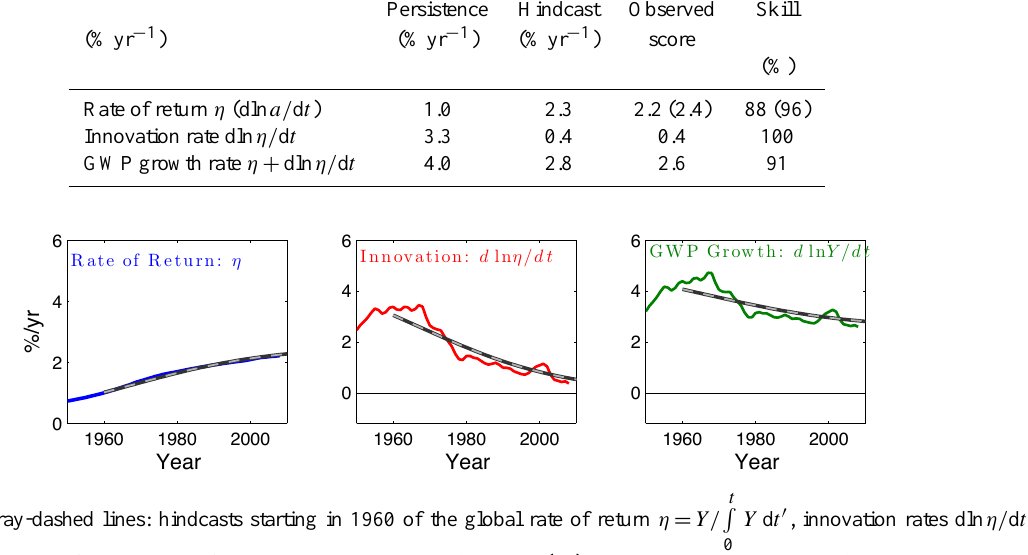
Table 1. For key economic parameters, a comparison between observed annual growth rates and 50-year predictions made assuming either a reference model of persistence or a hindcast model given by Eq. (11). Persistence is derived from historical rates between 1950 and 1960. The “observed” time period is 2000 to 2010. The skill score is derived from 1 − error(hindcast)/error(persistence), where error is derived relative to observed rates. Data are shown in Fig. 7.